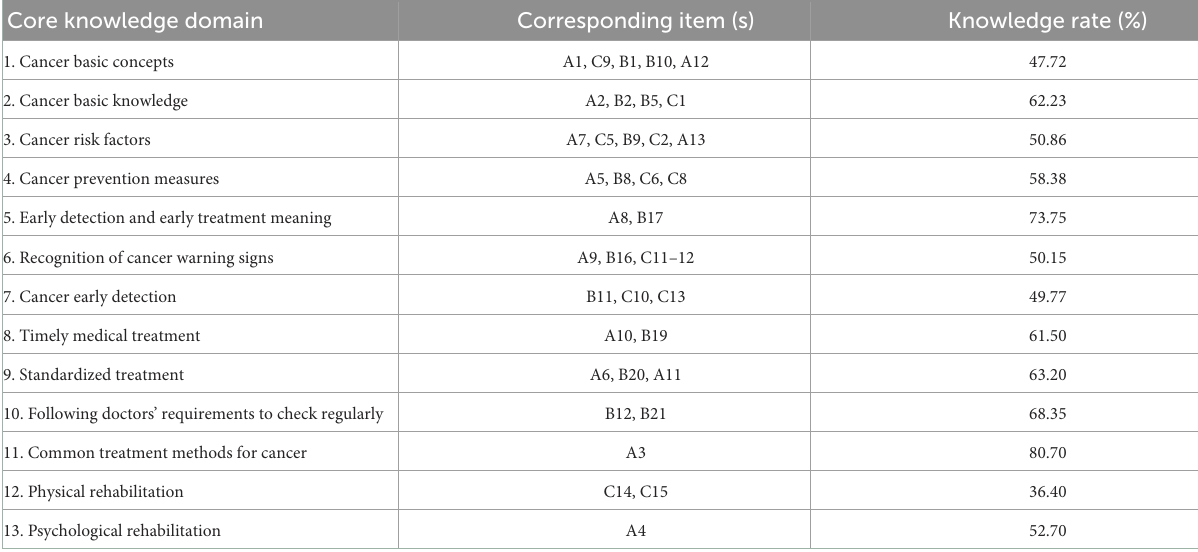
TABLE 2 Rates of cancer prevention and control core knowledge by survey domain ( n = 2,074). Core knowledge domain